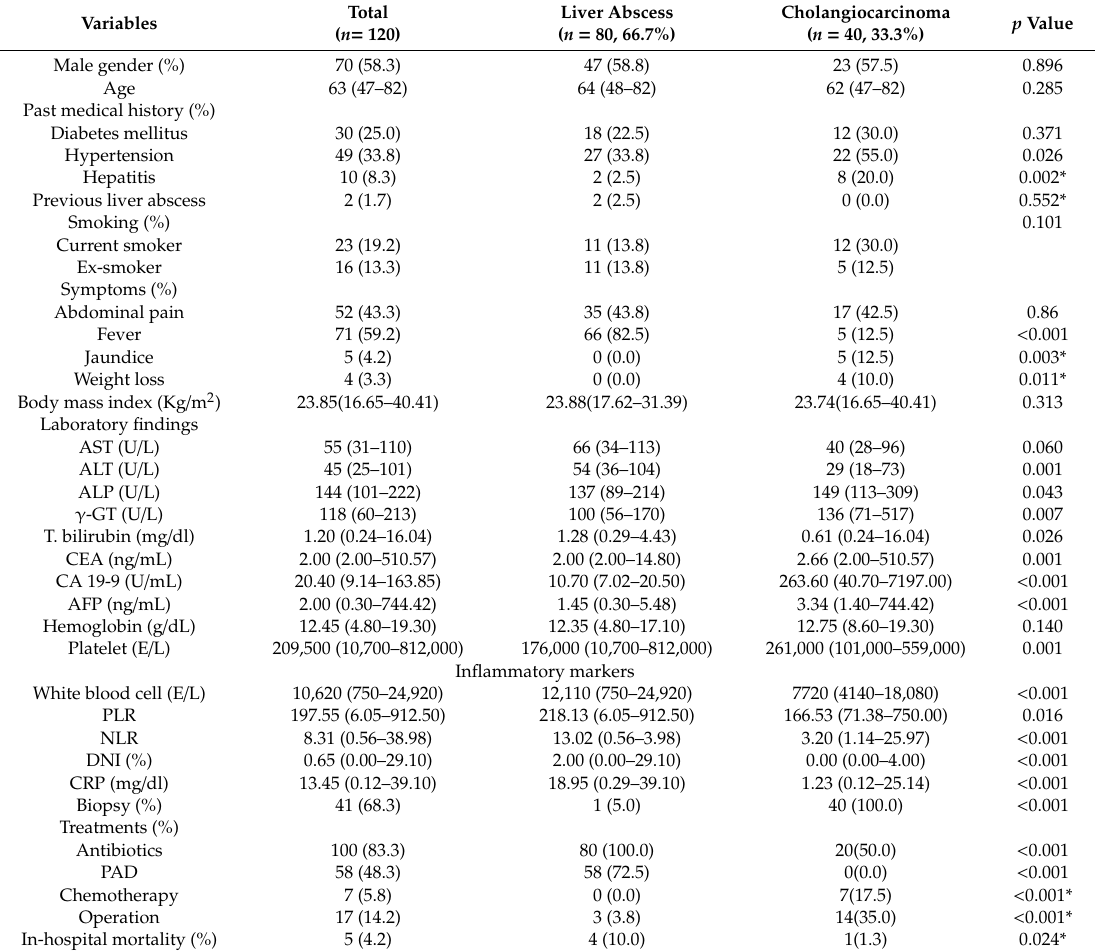
Table 1. Baseline characteristics in age and sex matched